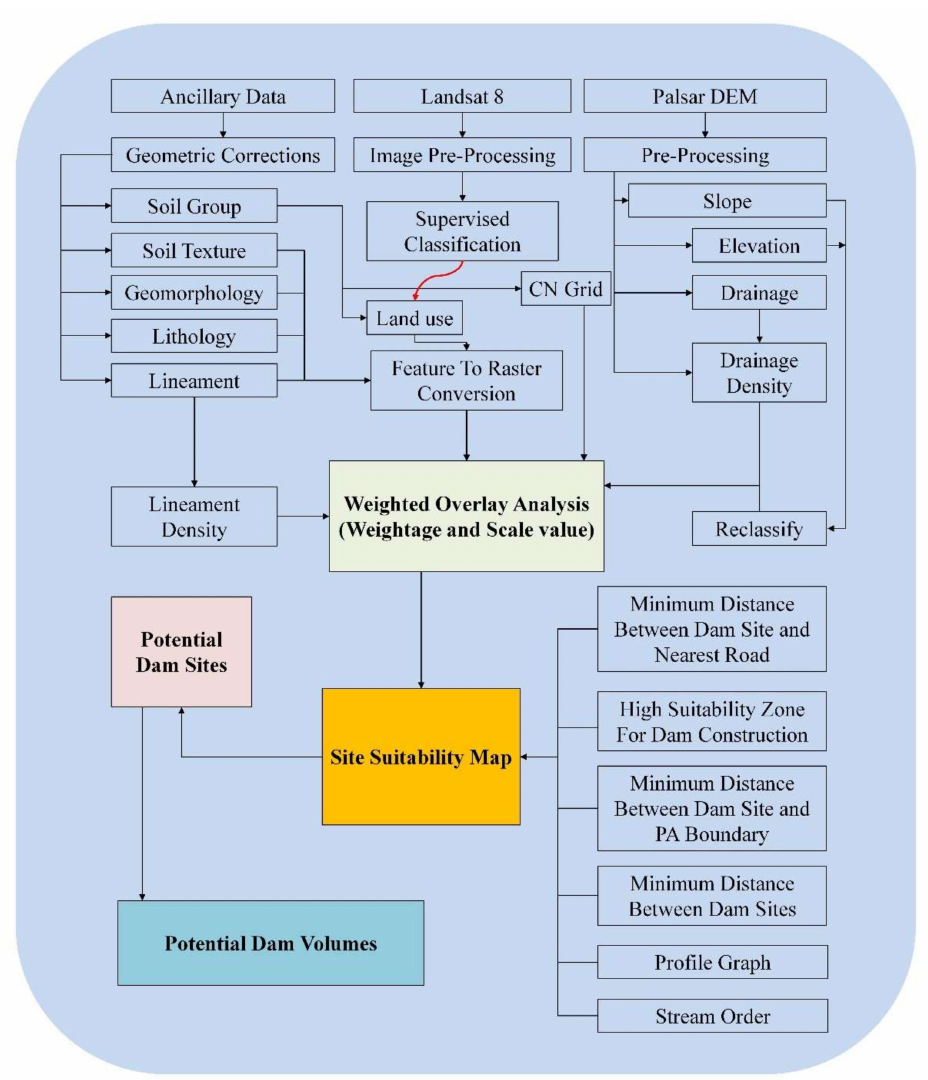
Figure 2. Overall methodology of the work shown using a hierarchy